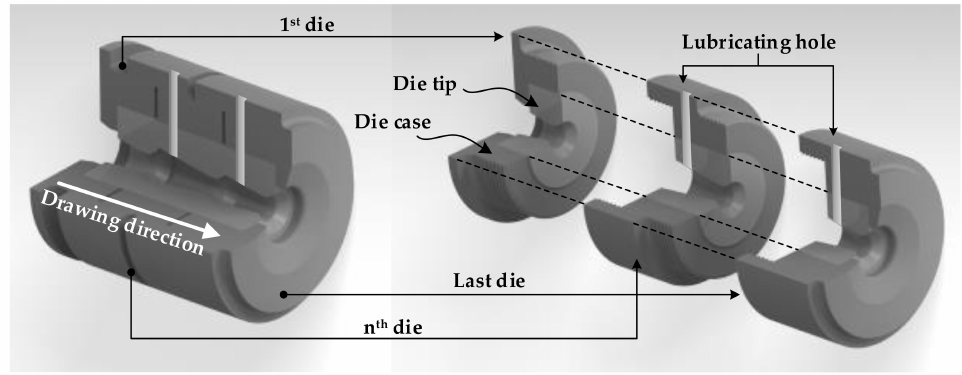
Figure 1. Schematic illustration of the multiple reduction die (MRD).